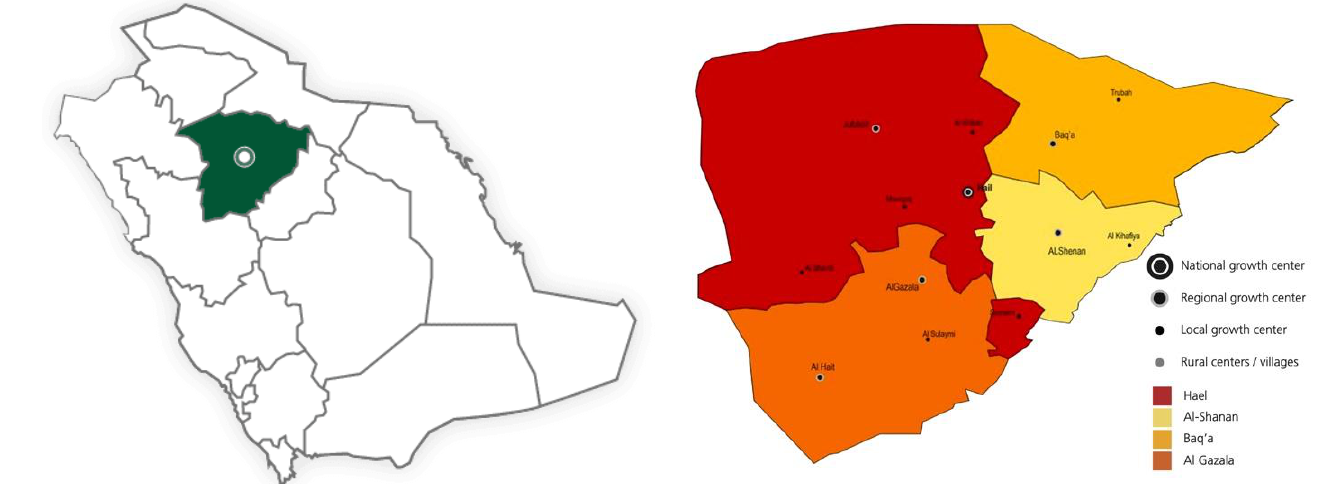
Figure 3. Hail region location and administrative boundaries.